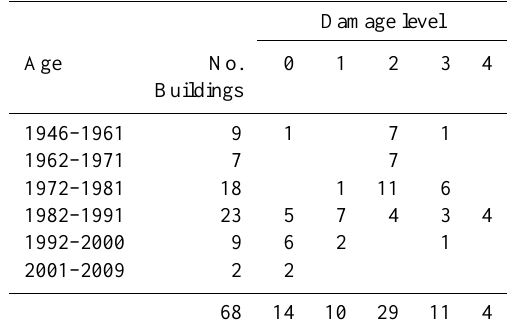
Table 1. Distribution of damage levels of surveyed RC